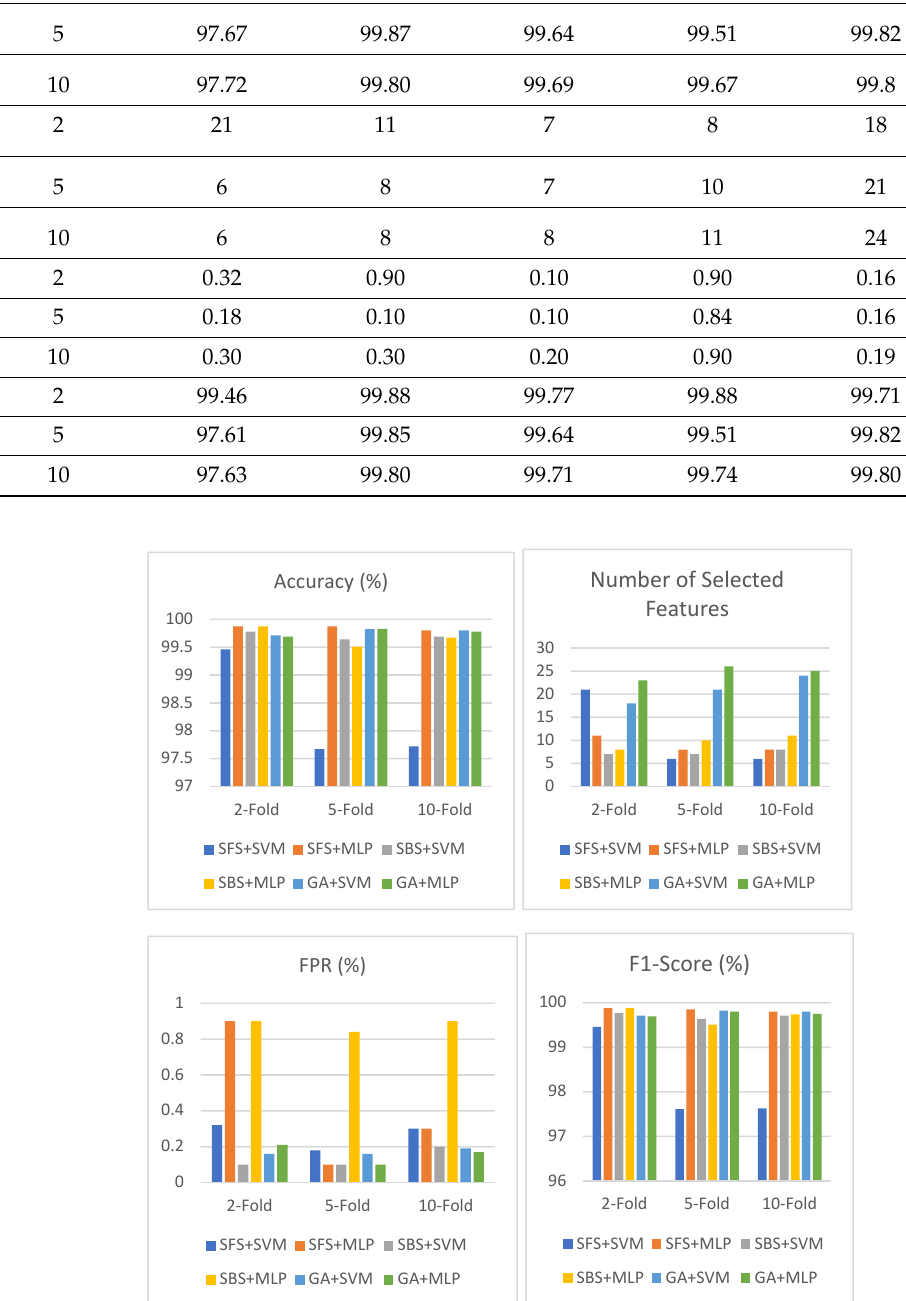
Table 8. Performance of SFS, SBS, and GA using objective function based on accuracy and number of selected features in CIC-IDS-2018. Metric